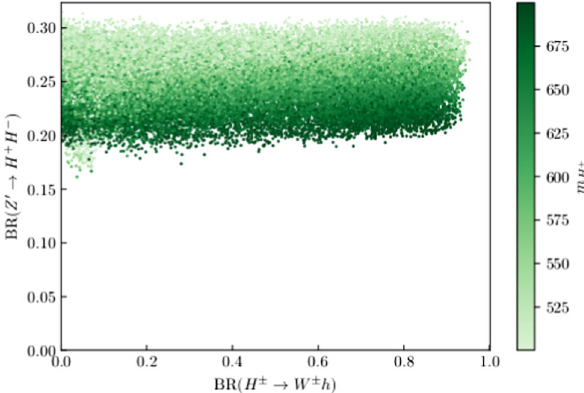
Fig. 5 Branching ratios for A 0 → b ¯ b versus versus H 2 → H 1 H 1 resulting from the parameter space scan in scenario 2. The colour grad- ing is related to the value of BR ( Z (cid:2) → H 2 A 0 ) as shown on the